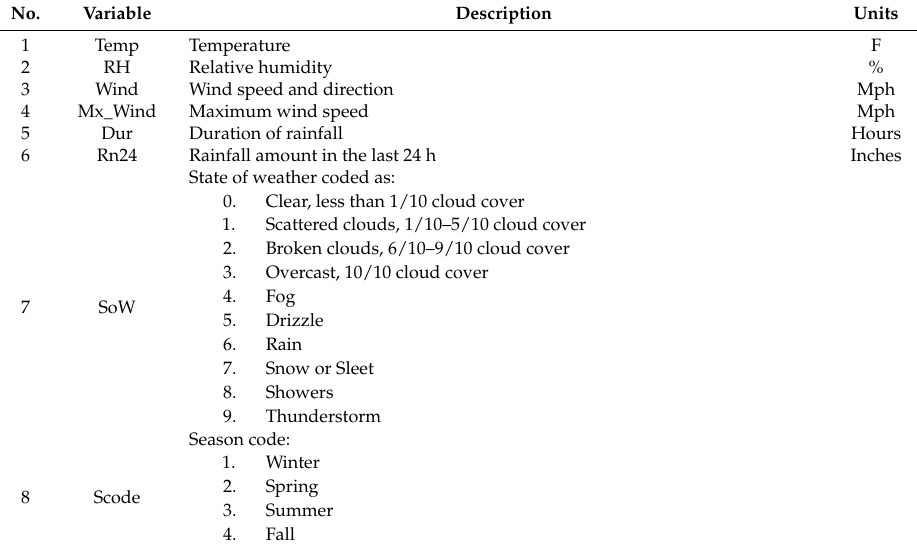
Table A1. Dataset of variables in fire danger